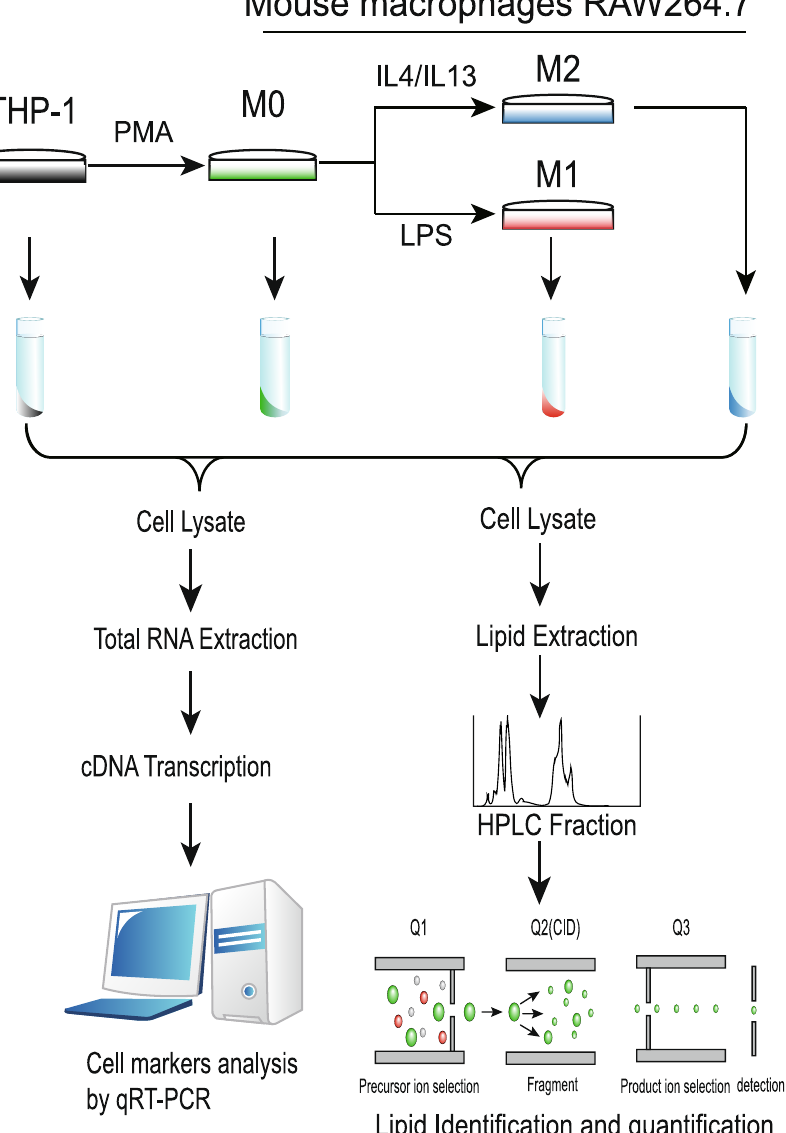
Figure 1. Schematic diagram of macrophage polarization and lipid